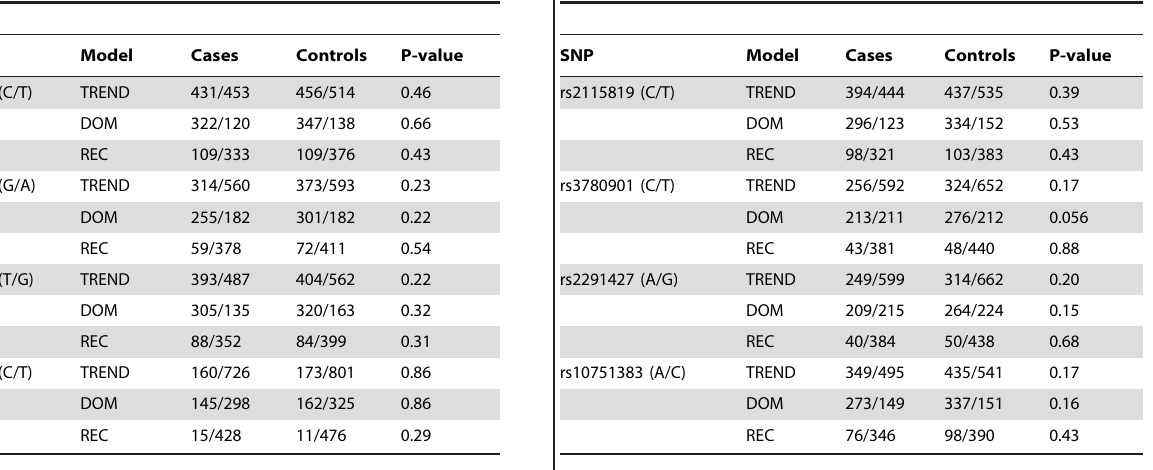
Table 2. Associations between the CYP4F3 gene and CD in Canadian children.